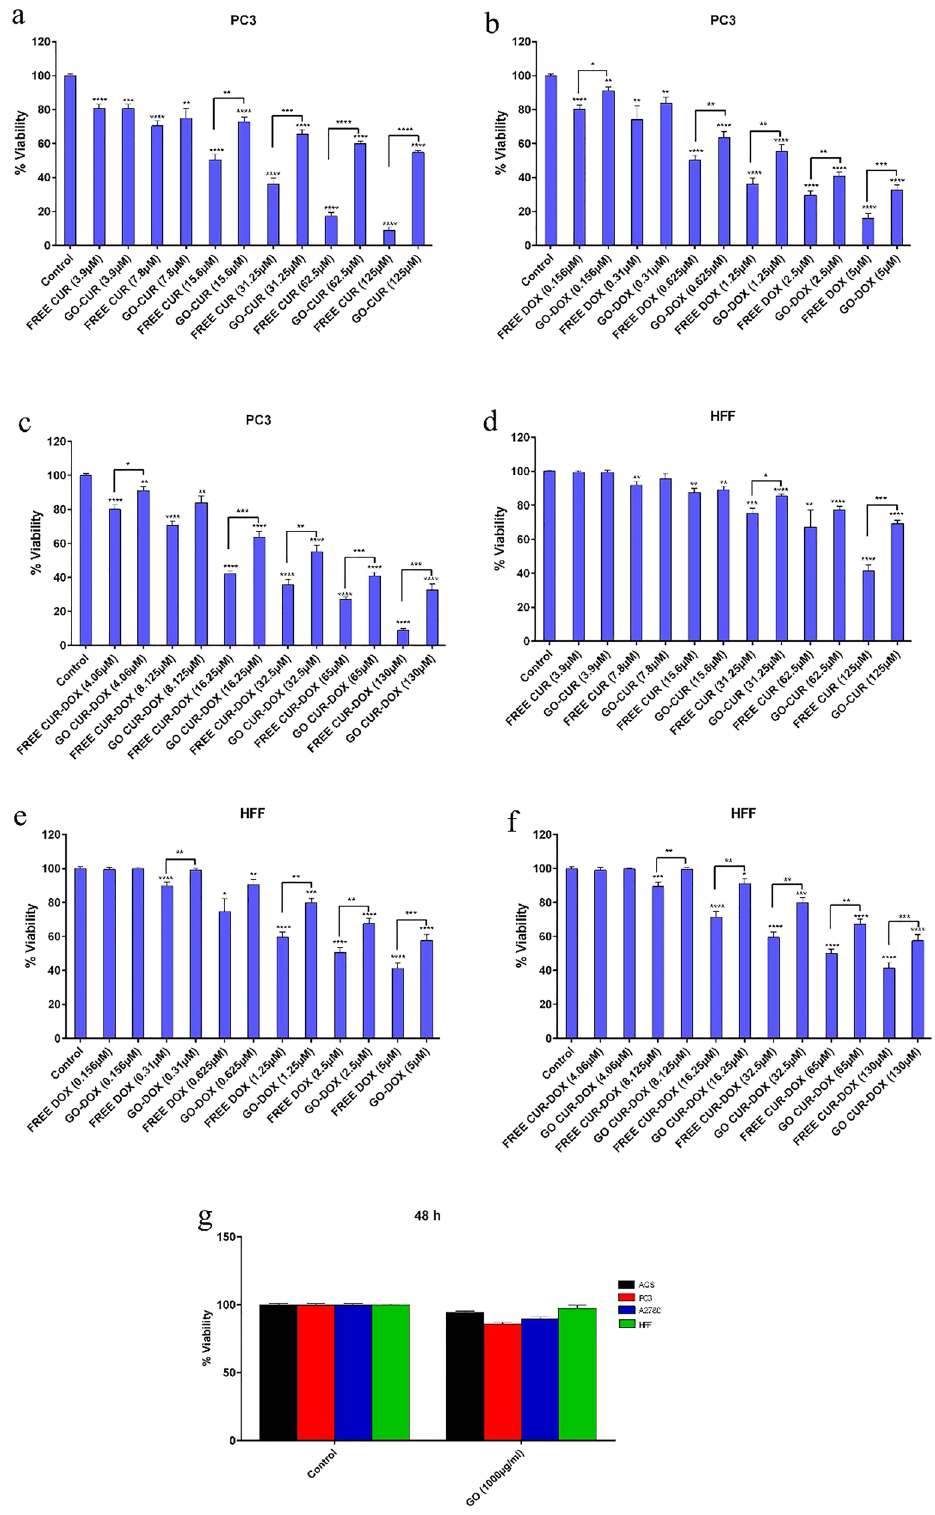
Figure 11. Cytotoxicity analysis of ( a ) different concentration of free CUR and GO-CUR in PC3 after 48 h; ( b ) different concentration of free DOX and GO-DOX in PC3 after 48 h; ( c ) different concentration of free CUR- DOX and GO-CUR-DOX in PC3 after 48 h; ( d ) different concentration of free CUR and GO-CUR in PC3 after 48 h; ( e ) different concentration of free DOX and GO-DOX in PC3 after 48 h; ( f ) different concentration of free CUR-DOX and GO-CUR-DOX in PC3 after 48 h; ( g ) free GO-COOH in AGS, PC3, A2780 and HFF after 48